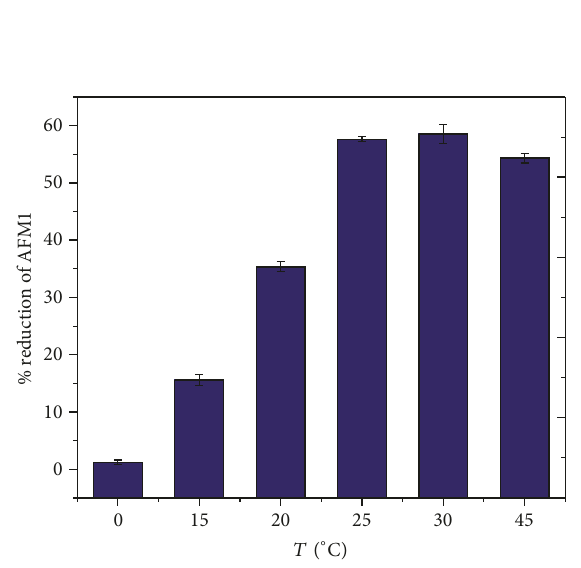
Figure 4: Effect of incubation temperature on AFM1 reduction during ergo